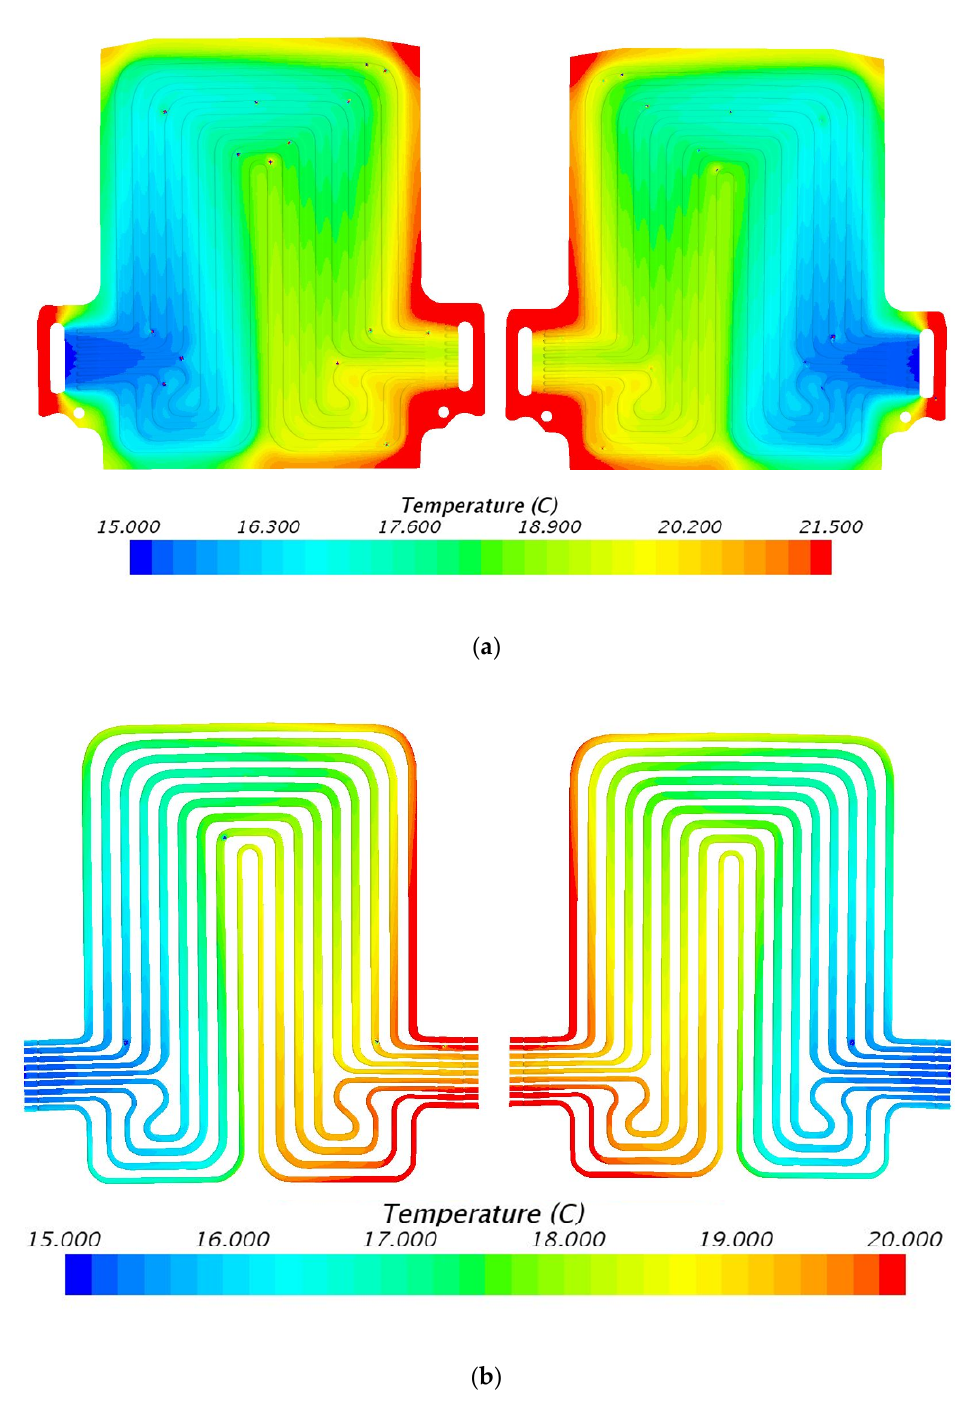
Figure 12. Temperature profile at 80 A and 15 °C with heat flux values near cathode = 2419.0 W/m 2 , anode = 2887.1 W/m 2 , and mid surface = 697.3 W/m 2 . ( a ) Top view and ( b ) bottom view.